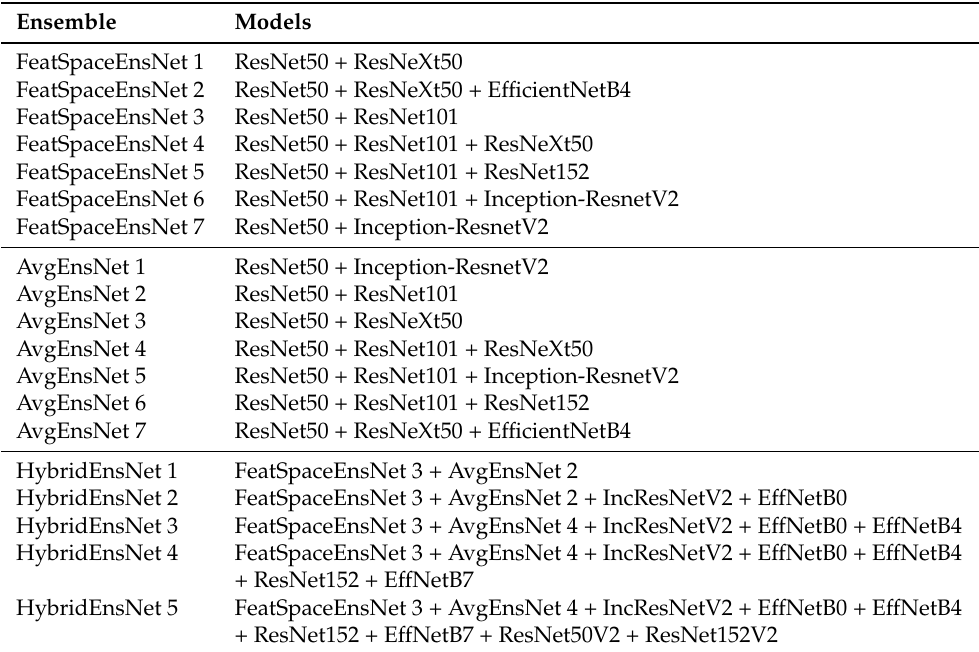
Table 1. Ensemble